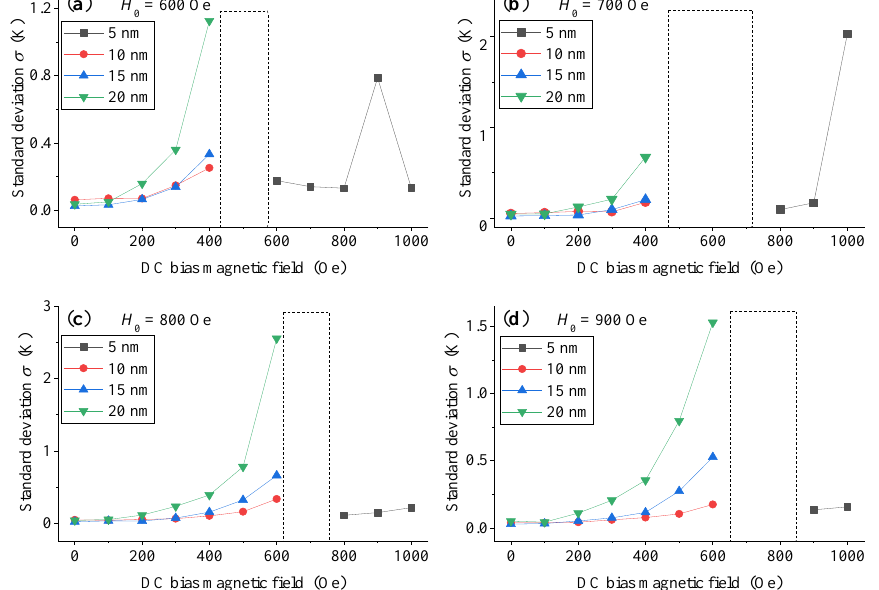
Figure 9. The standard deviation of the large-size MNPs (10 nm, 15 nm and 20 nm) when H dc is smaller than the conversion magnetic field and the standard deviation of the small-size MNPs (5 nm) when H dc is larger than the conversion magnetic field.